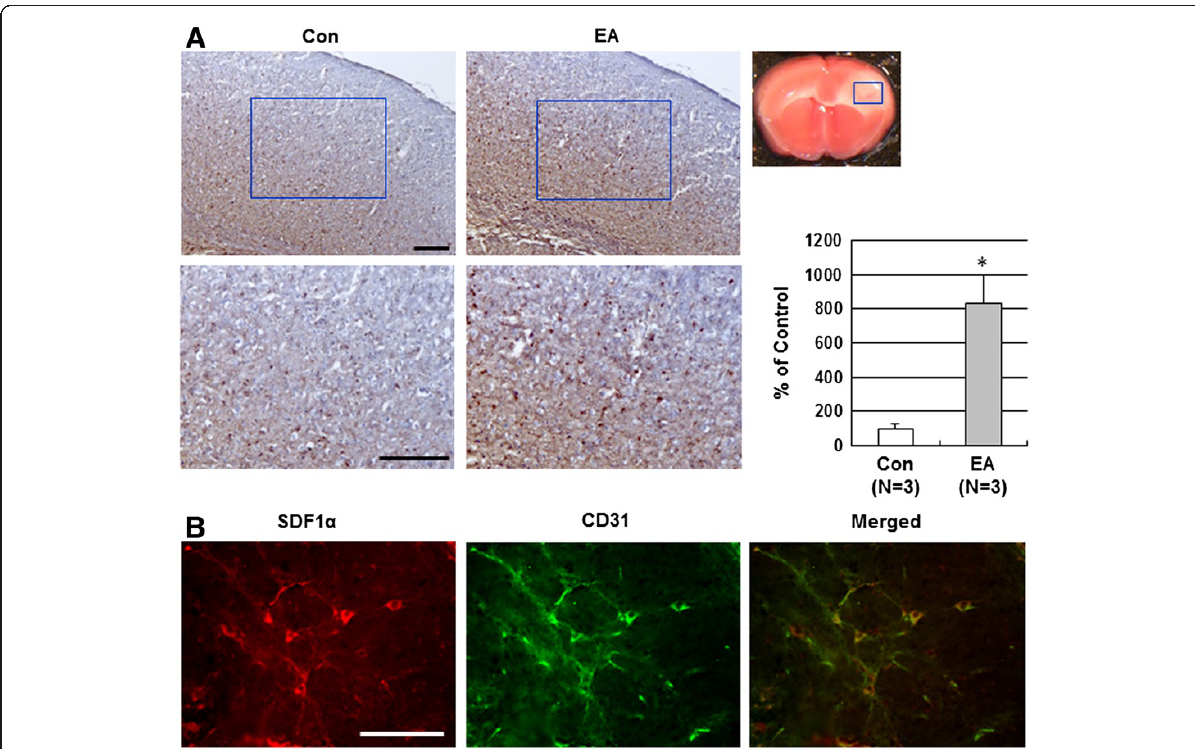
Figure 5 Effect of EA preconditioning on SDF-1 α expression in ischemic brain. (A) Representative immunohistochemical staining showed SDF-1 α -positive cell expression 24 h after occlusion in the ischemic cortex of mice that received control or EA. The blue rectangle represents the imaging field. Quantification of SDF-1 α -positive cells is expressed as the % change of the control. The results are expressed as mean ± SEM for three mice in each group. * , P <0.05 vs. control (Con). (B) Representative double immunofluorescence staining for SDF-1 α (red) and CD31 (endothelial cell marker, green) in EA-preconditioned ischemic brain. EA-induced SDF-1 α was colocalized with the endothelium after ischemic injury. Scale bar = 100 μ